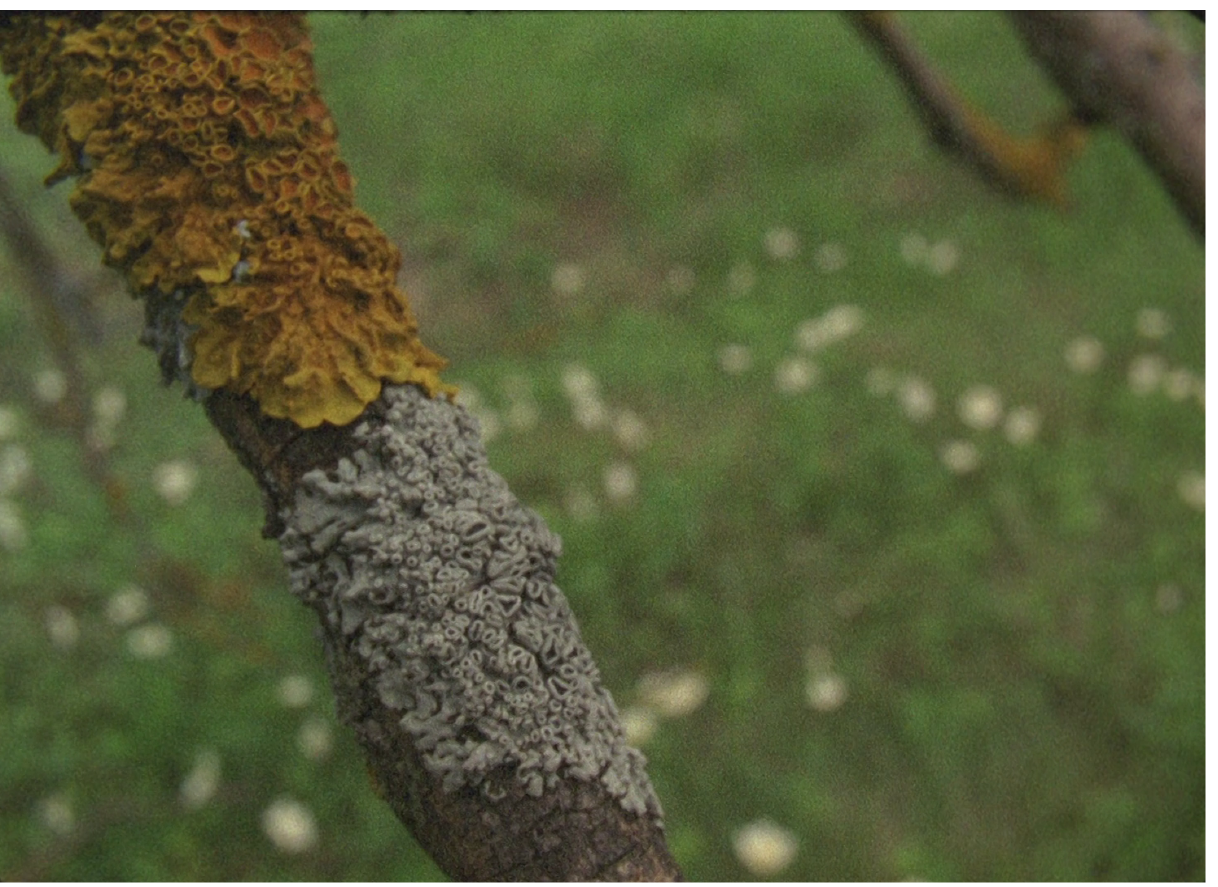
Figure 8. Lichens, film still from Elke Marhöfer , Becoming Extinct (Wild Grass) , 2017 (© Elke